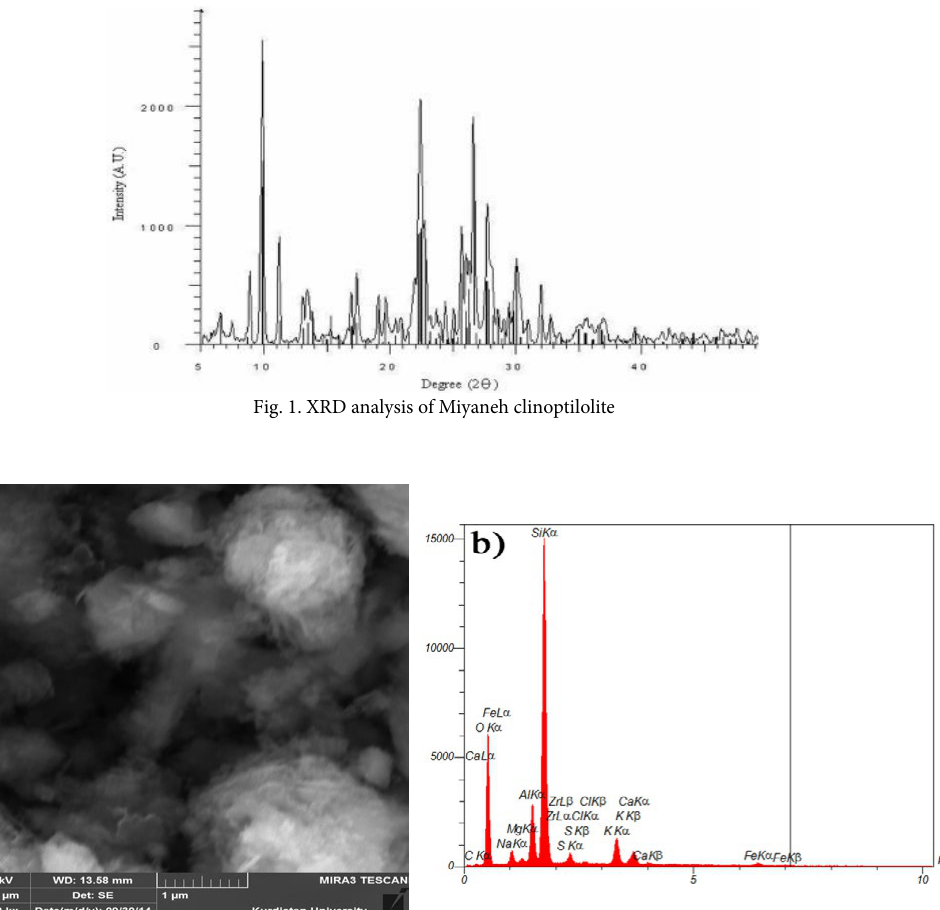
Figure 2: Scanning electron microscopy (SEM) image (a) and EDX analysis (b) of nanozeolite